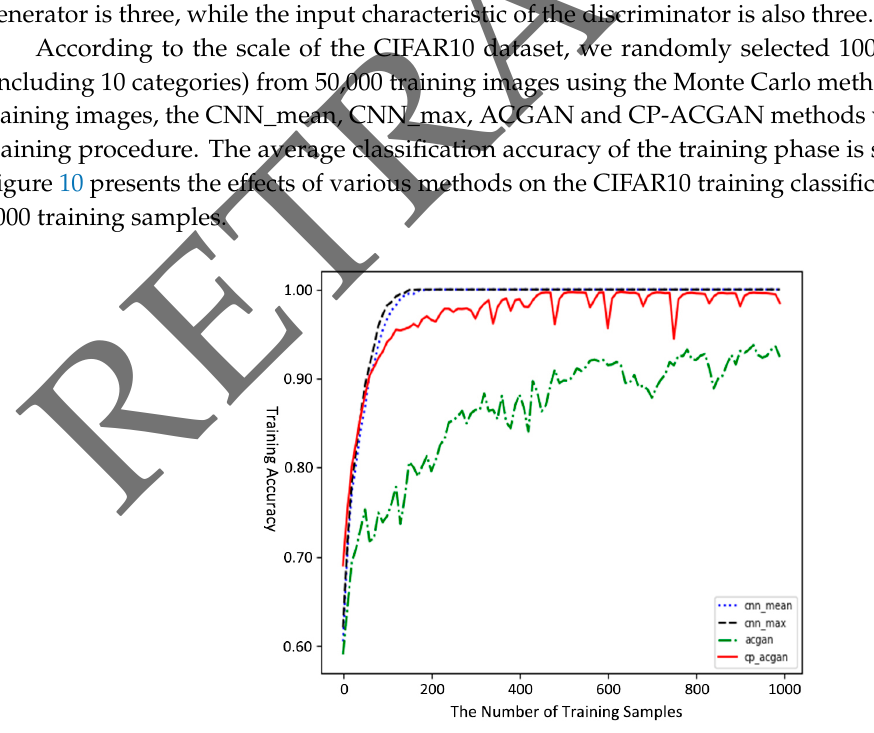
Figure 10. Average classification accuracy of different methods on the CIFAR10 training dataset.